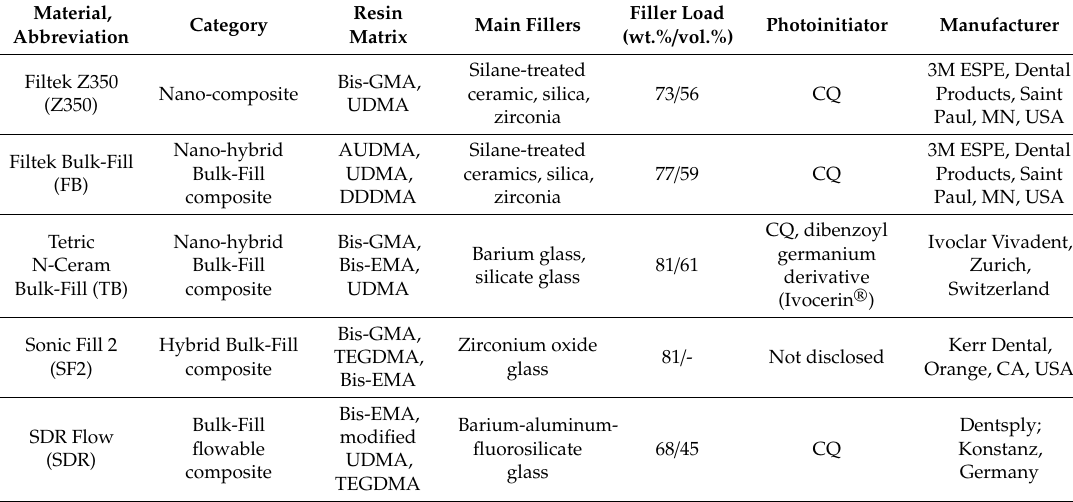
Table 1. Summary of the resin composite products used in the